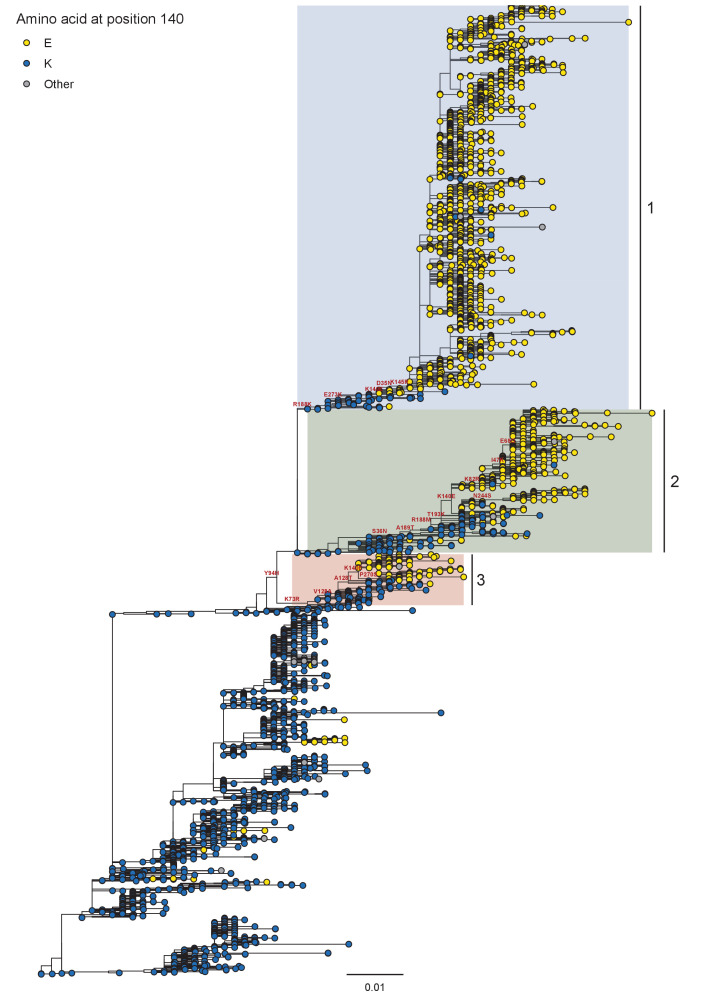
Phylogeny of A/H1N1 seasonal viruses for the period 1999 to 2008.Branch tip color indicates the amino acid identity at position 140. Co-circulating lineages defined by the K140E fixation are highlighted. Scale bar indicates the number of nucleotide substitutions per site. Tree rooted to A/New Caledonia/20/1999.